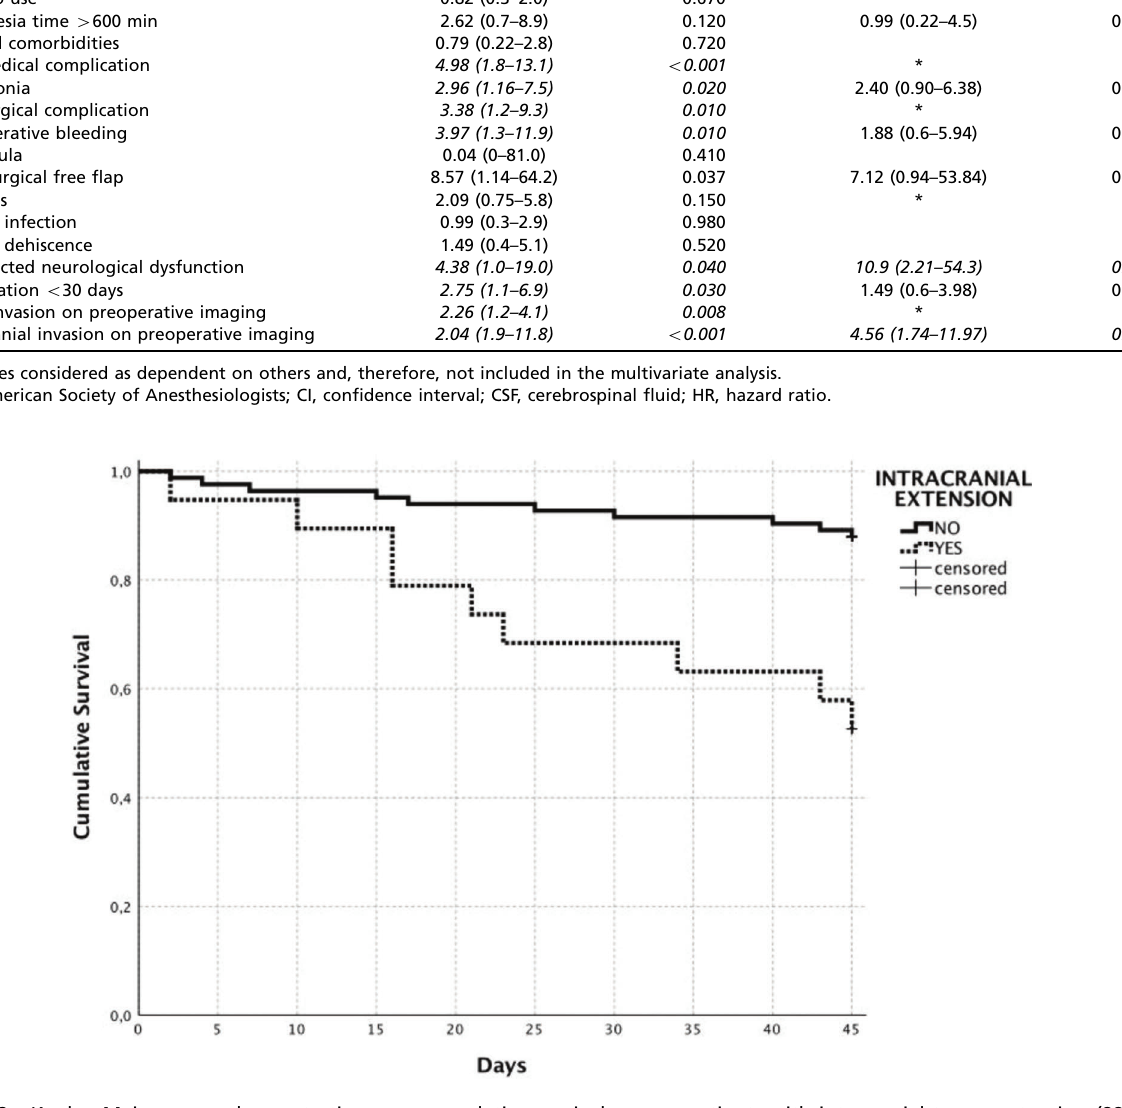
Figure 2 - Kaplan-Meier curves demonstrating poor cumulative survival among patients with intracranial tumor extension (88.0 vs. 52.6%; p o 0.001; log-rank